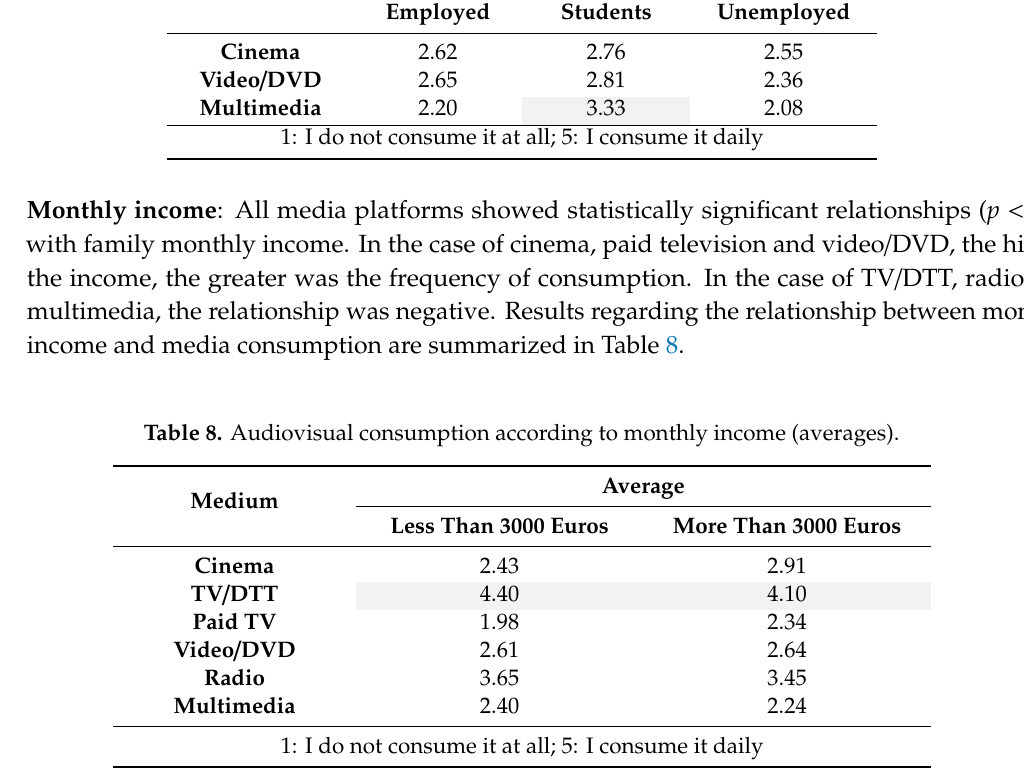
Table 7. Cinema, video / DVD, and multimedia consumption according to occupation (averages). Average Medium Employed Students